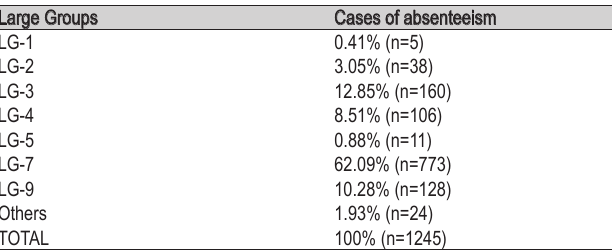
Table 1 - Distribution of cases of absenteeism in relation to the Large Groups of the Brazilian Classification of Occupations (BCO-2002).